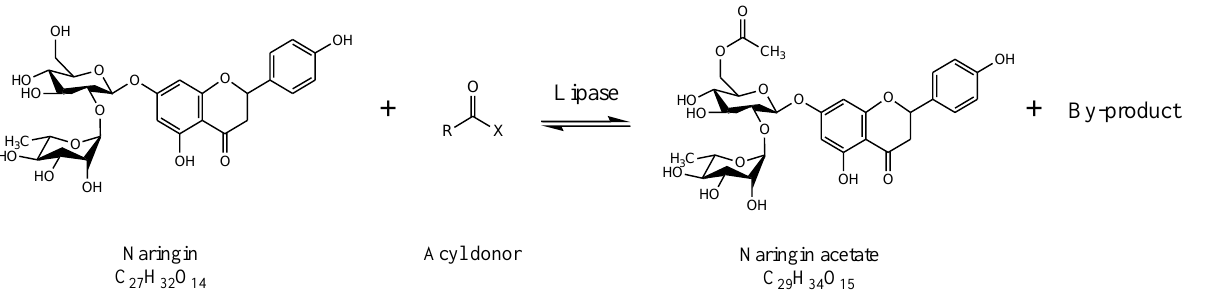
Figure 1. Reaction formula for the production of naringin acetate from naringin and acyl donors.